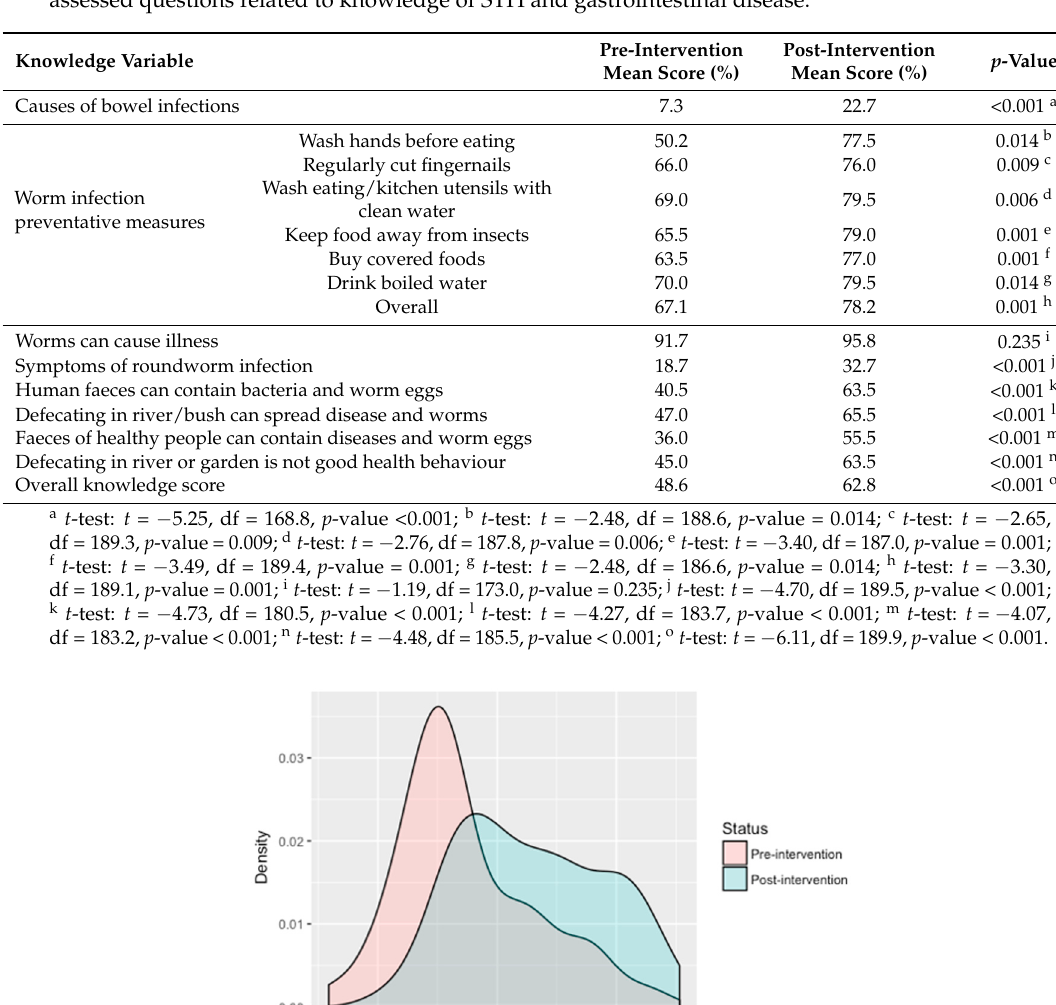
Table 1. Comparison of participant knowledge scores pre- and post-intervention for each of the assessed questions related to knowledge of STH and gastrointestinal disease.